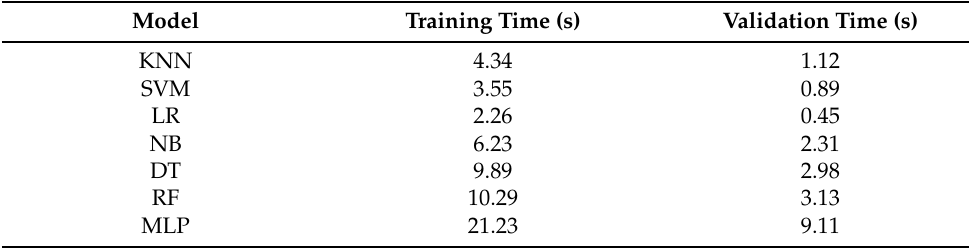
Table 11. Average training and validation time for all models.